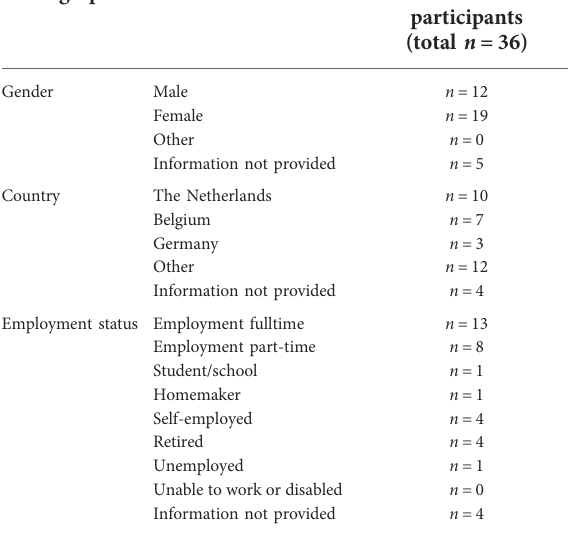
TABLE 3 Demographics of participants.